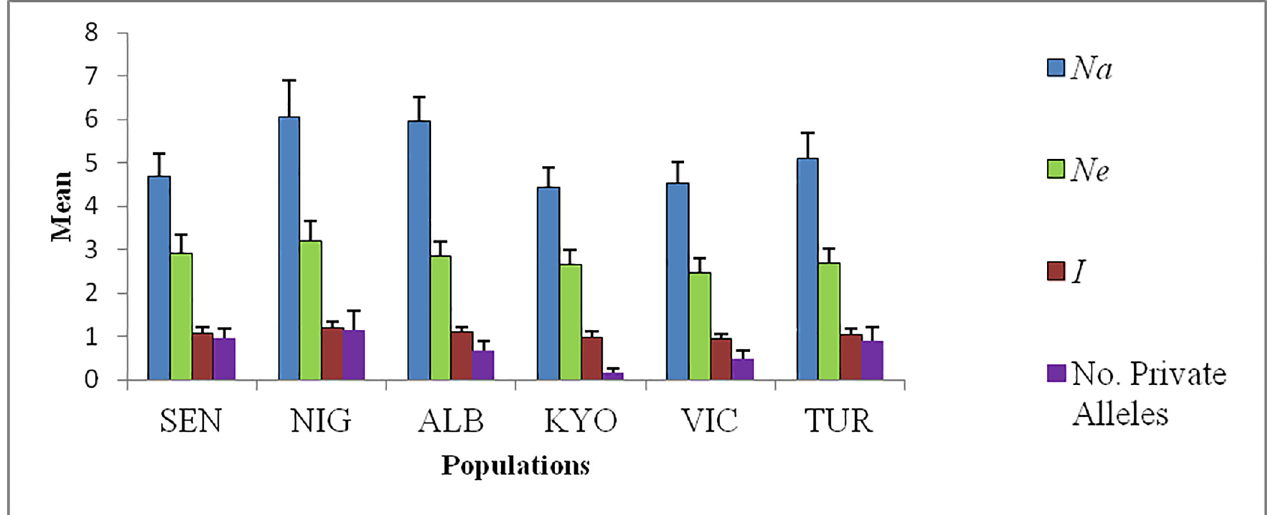
Fig 1. Mean allelic patterns in Nile perch plotted against each population. The Y–axis, shows the mean number of alleles ( Na ), Ne , mean number of effective alleles and Mean number of private alleles, while the X- axis shows the populations; SEN—Senegal, NIG—Lake Kainji on the Niger River, ALB- Lake Albert, KYO- Lake Kyoga, VIC- Lake Victoria and TUR- Lake Turkana. Error bars represent standard error